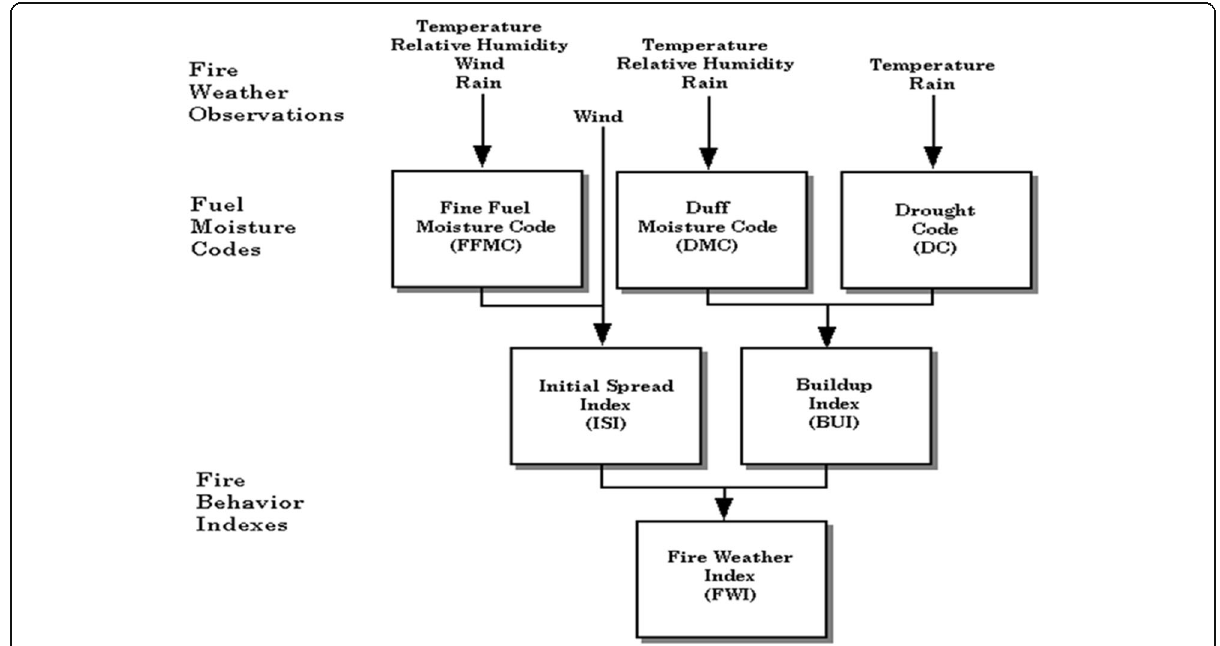
Fig. 2 The inputs and outputs and calculation flow of the Canadian Forest Fire Weather Index (FWI) System (Van Wagner